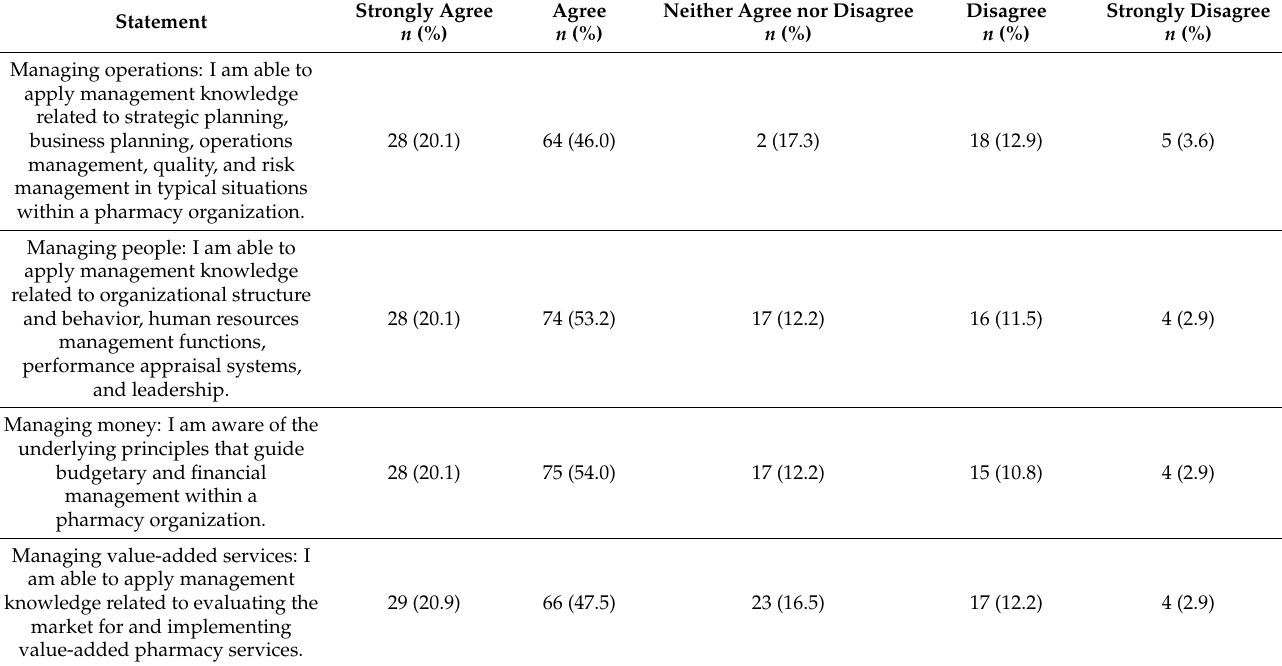
Table 5. Ability to use pharmacy financial management knowledge in practice ( n =